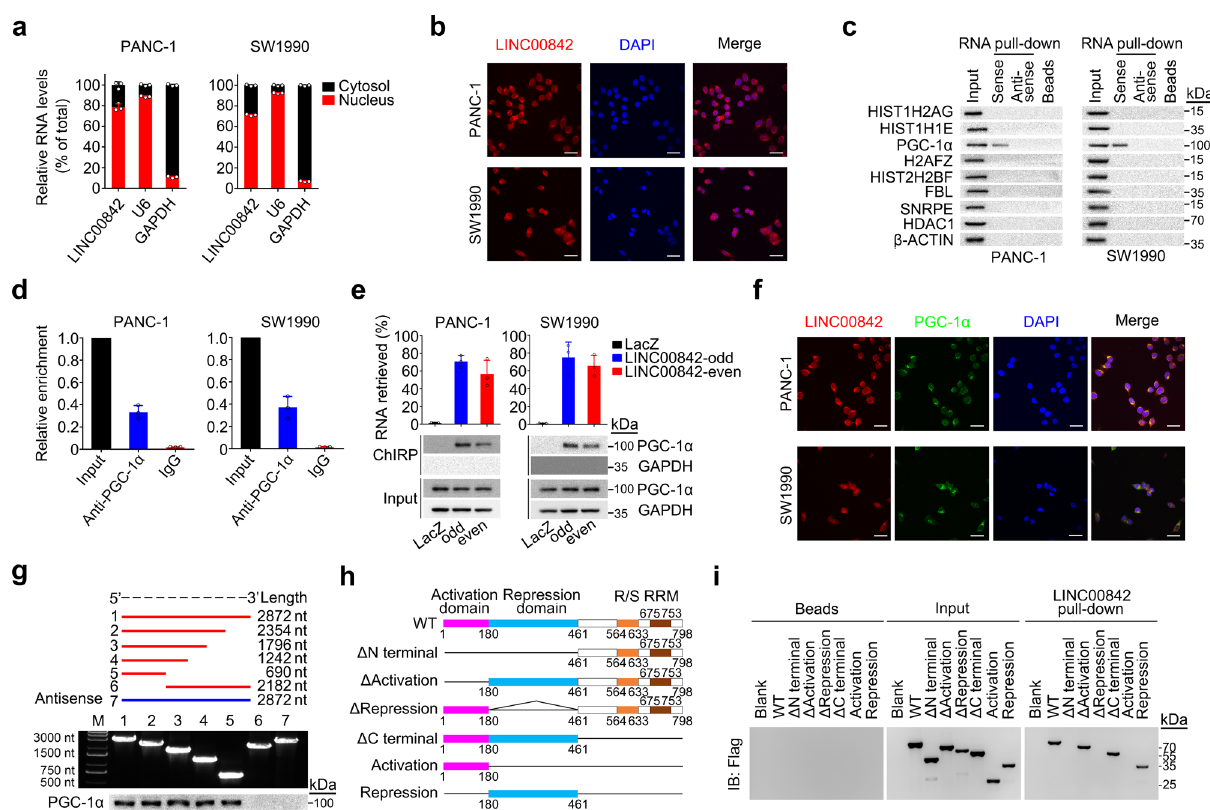
Fig. 4 LINC00842 directly interacts with PGC-1 α in PADC cells. a , b Subcellular localization analysis by PCR ( a ) or RNA FISH ( b ) shows LINC00842 is mainly located in the nuclei. U6 and GAPDH were served as nuclear and cytoplasmic markers and shown are mean ± SD from 3 independent experiments ( a ). Scale bar, 30 μ m ( b ). c Western blot analysis of proteomic screening suggested 8 potential LINC00842 -binding proteins obtained from RNA pull-down assays with LINC00842 or its antisense. d Association of PGC-1 α with LINC00842 determined by RNA immunoprecipitation (RIP) assays. Data represent relative enrichment (mean ± SD) to input from 3 independent experiments. IgG was used as the negative control. e Results of chromatin isolation by RNA puri fi cation (ChIRP) assays using LINC00842 -odd, -even or LacZ (negative control) antisense probe sets. Upper panels are RNA retrieval rate (mean± SD from 3 assays) and lower panels are immunoblot of PGC-1 α and GAPDH (negative control) in ChIRP and input. f Immuno fl uorescence assays show co- localization of LINC00842 (red) and PGC-1 α (green) predominately in the nuclei. Scale bar, 30 μ m. g Truncation mapping of LINC00842 PGC-1 α binding domain. Top panel: diagrams of LINC00842 full-length and truncated fragments. Middle: RNA sizes of in vitro transcribed LINC00842 full-length and truncated fragments. Bottom: immunoblot analysis of PGC-1 α pulled down by different LINC00842 fragments. h Schematic diagram of Flag-tagged PGC-1 α and its truncated forms used in LINC00842 pull-down assays. i Immunoblot analysis of Flag-tagged wild-type (WT) PGC-1 α and its truncated forms retrieved by in vitro transcribed biotinylated LINC00842